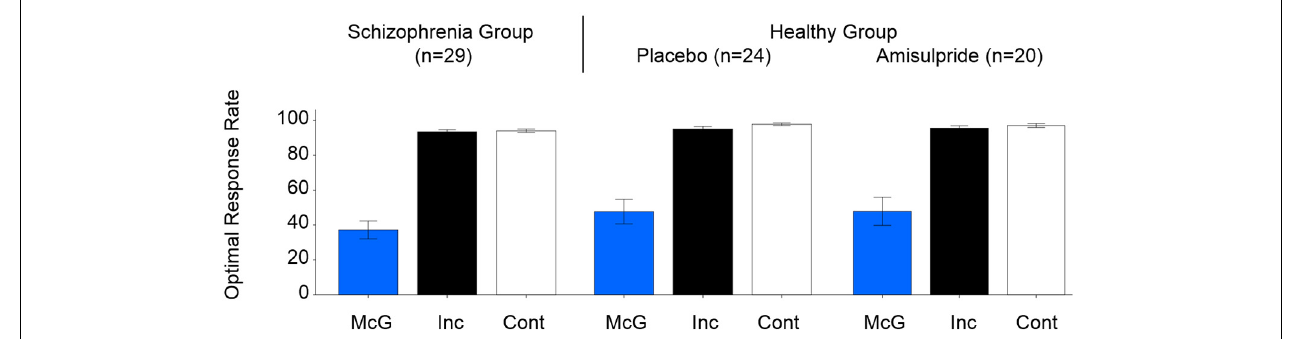
FIGURE 1 | Group-averaged perceptual performance for the three condition types, for the schizophrenia group (left), and the healthy group after placebo (center) and after amisulpride